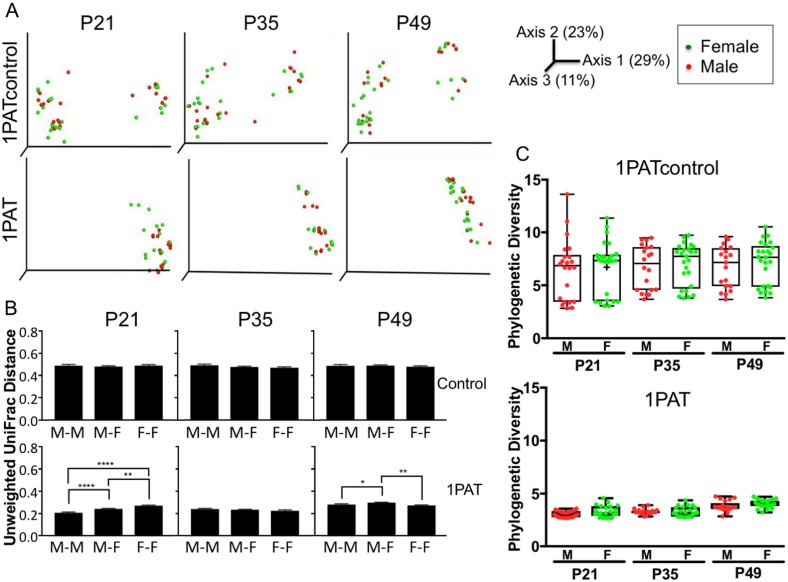
Fecal microbiota characteristics of male and female NOD mice in 1PAT and control groups in early life.(A) β-diversity, as measured by unweighted UniFrac analysis of fecal microbiota over time (P21, P35, and P49). (B) Inter- and intra-group UniFrac distances. Significance determined by one-way-ANOVA with Tukey method for correction for multiple comparisons. ****p<0.001. M-M, M-F and F-F represent the intra-group distances within males, inter-group distances between males and females, and intra-group distances within females, respectively. (C) α-diversity (Phylogenic diversity (PD)) of fecal microbiota. Statistical significance determined by one-way-ANOVA. ****p<0.0001.